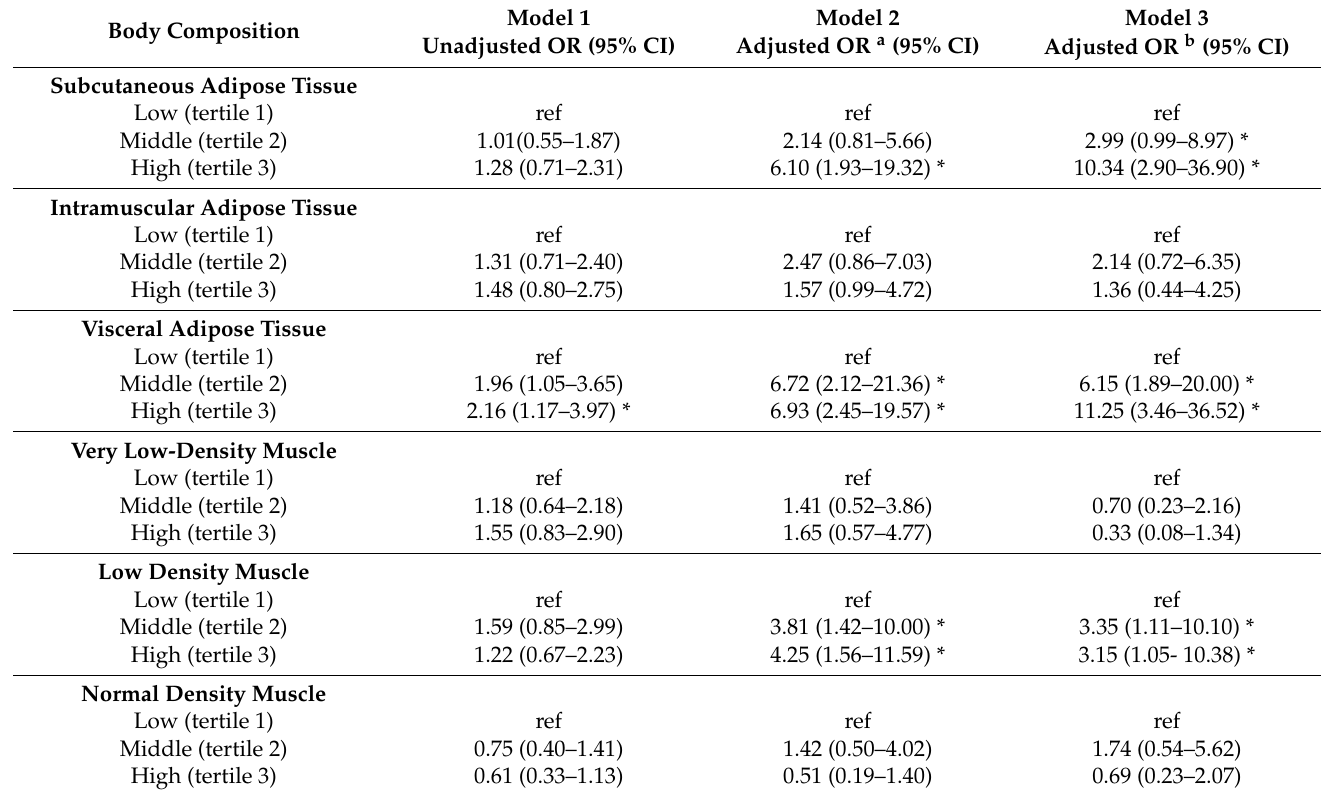
Table 2. Odds ratio (95% CI) for the association between specific body composition components and TNBC